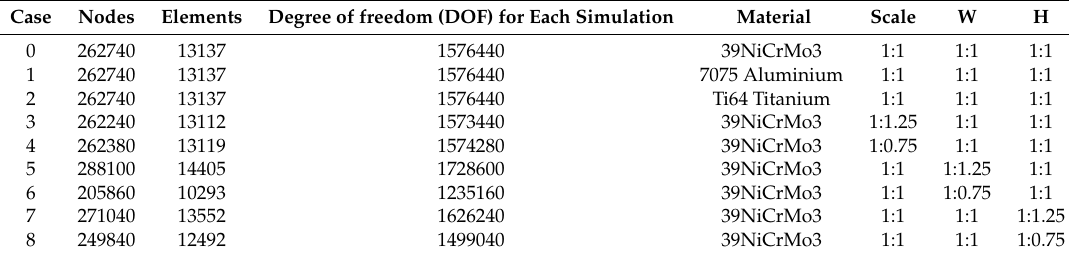
Table 1. Overview of preformed numerical